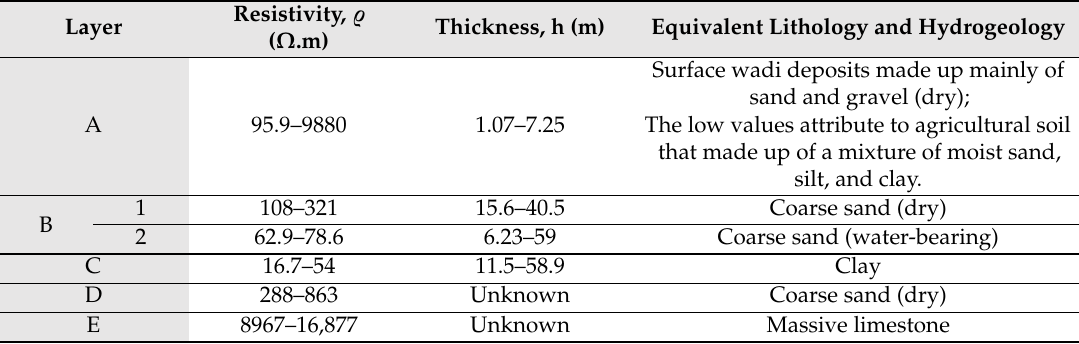
Figure 16. Calibration of the 1D model at VES-2 with the lithological log of Well-1. Table 1. Summary of geoelectric layers and their inferred lithology and